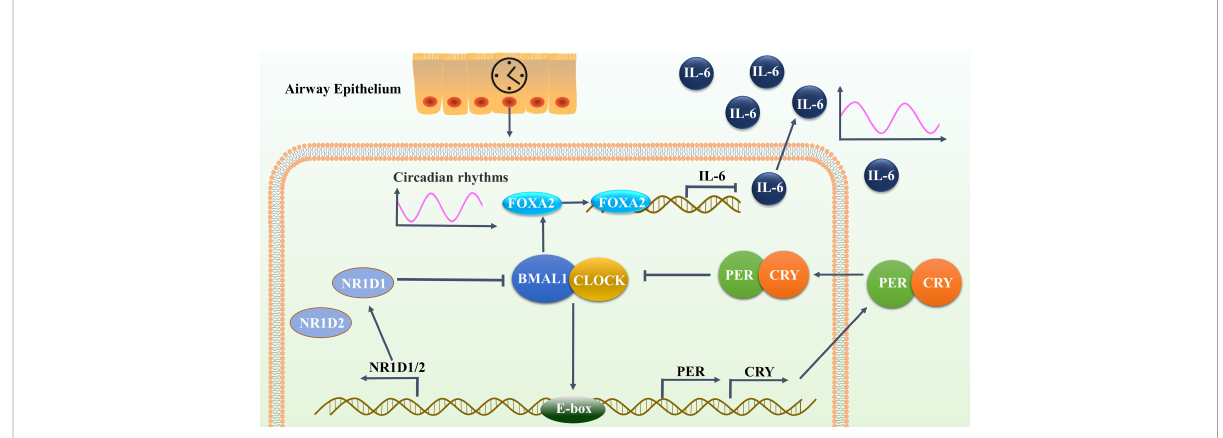
FIGURE 9 BMAL1 inhibited the expression and reduced the oscillation of IL-6 in airway epithelial cells by regulating the transcription factor FOXA2. This autoregulatory feedback loop cycles between the CLOCK/BMAL1 transcriptional activator complex and its repressors PER/CRY and NR1D1 to constitute the molecular clock oscillator in the airway epithelium, that drives the oscillatory activity of FOXA2. FOXA2 could bind to the promoter region of IL-6 and down-regulate its expression, resulting in periodic oscillations in the secretion level of